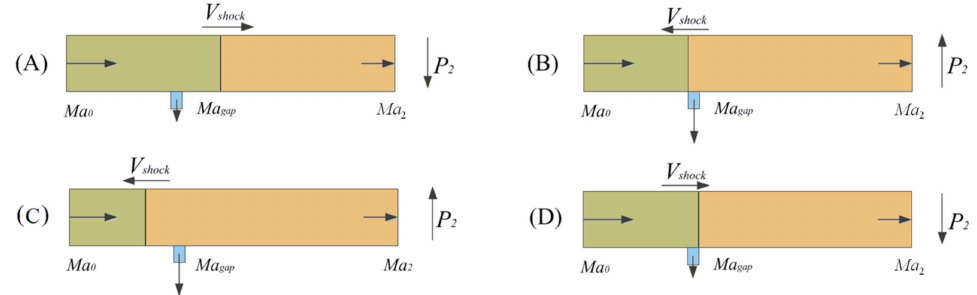
Figure 7. Shock wave periodic motion process.